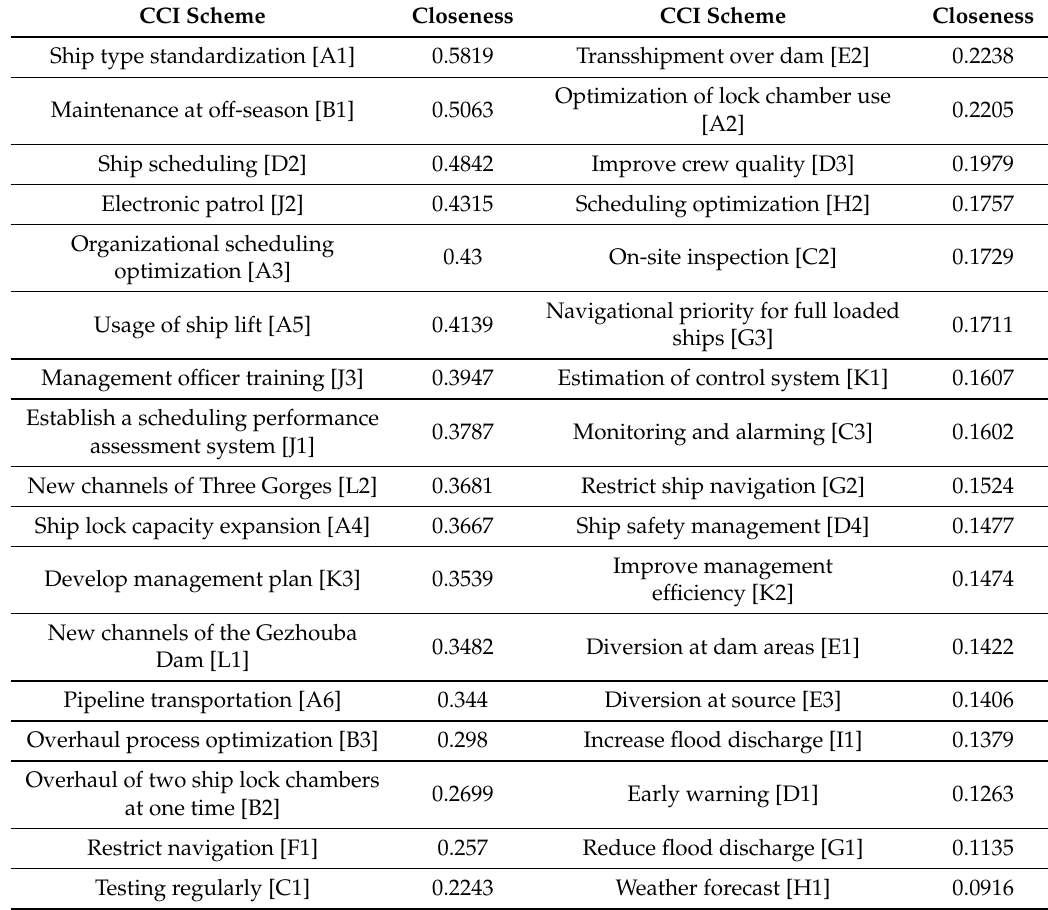
Table 12. Performance of CCI schemes of different